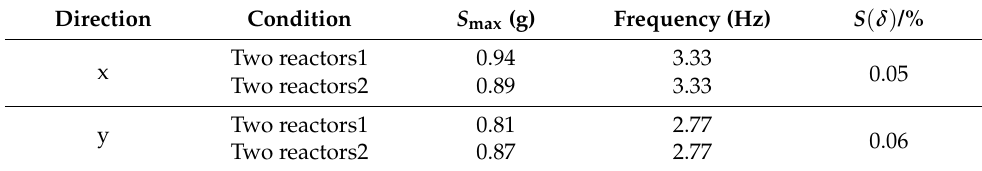
Table 5. Comparison of FRS at different locations of raft foundation (2–10 Hz).